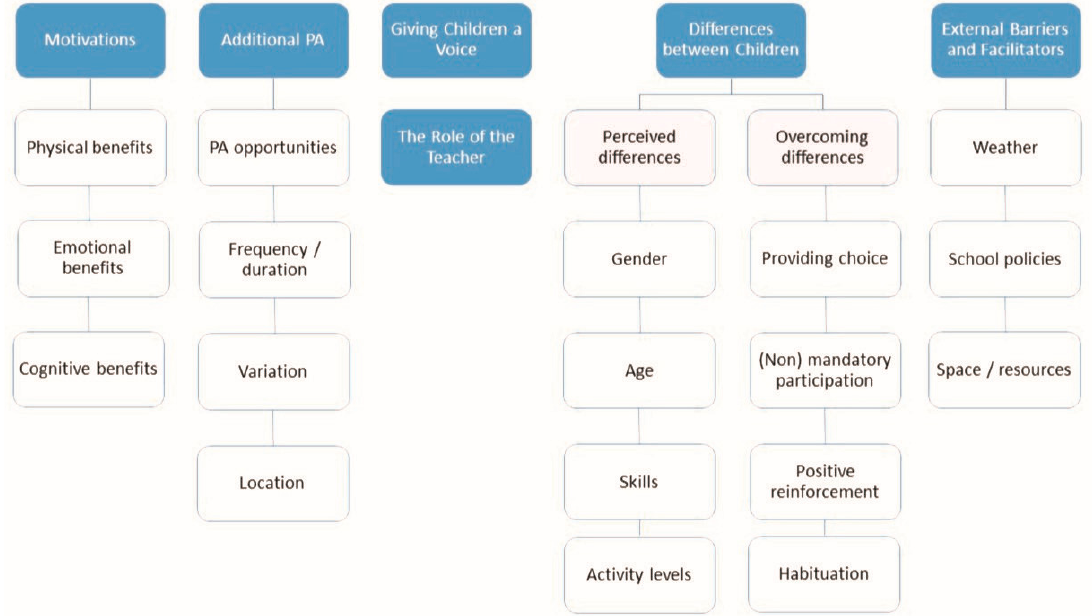
Figure 1. An overview of all themes and subthemes resulting from the analysis. PA: physical activity.